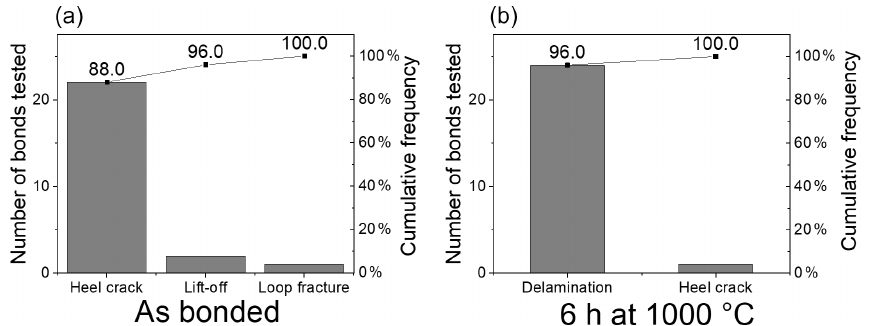
Figure 10. Frequency of failure mechanisms of wire bonds, for different ageing conditions, bonded to thin film. (a) No annealing and (b) aged for 6h at 1000 ◦ C.